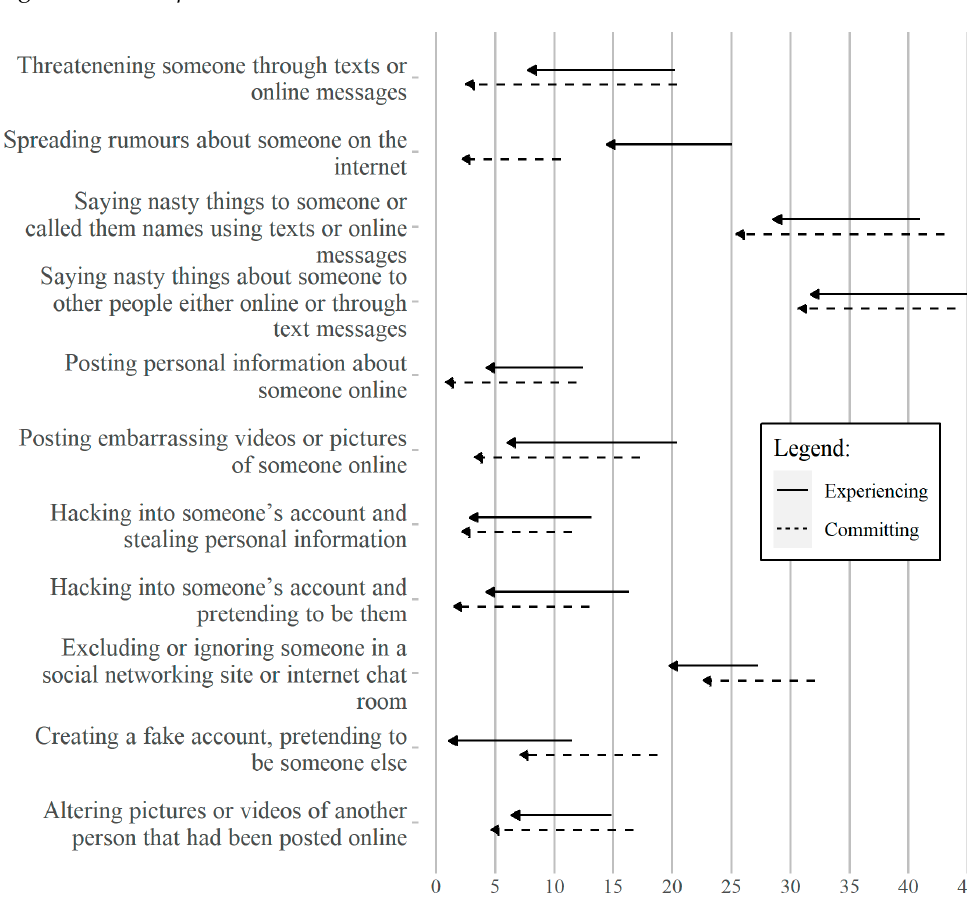
Figure 1. Percentages of adolescents who experienced and who committed cyberviolence in 2017 and 2020 (all statistically significant with p < 0.05) .